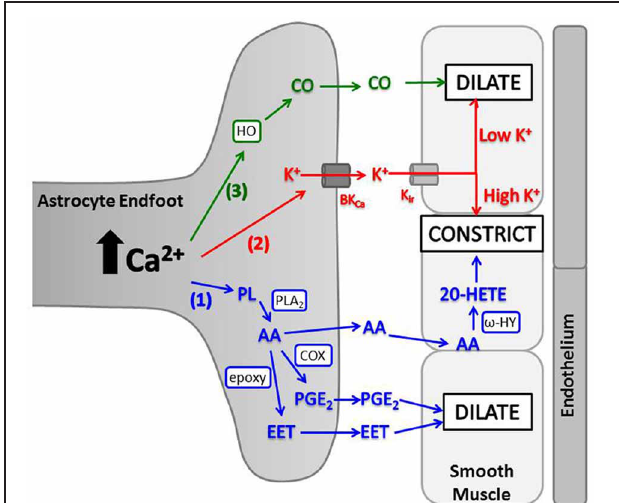
FIGURE 3 | Astrocyte intracellular Ca 2 + elevations trigger release of vasoactive molecules. (1) PLA 2 is activated by Ca 2 + and converts phospholipids (PL) to AA. AA is metabolized in astrocyte endfeet to PGE 2 (by COX) or EET [by cytochrome P450 epoxygenase (epoxy)] which dilate arterioles, or AA can diffuse to smooth muscle where ω -hydroxylase ( ω -HY) converts it to 20-HETE and causes constriction. (2) K + is released from astrocyte endfeet through BK Ca , and the amount of K + released is directly proportional to astrocyte Ca 2 + level. K + is taken up into smooth muscle through K ir and causes dilation at low concentrations and constriction at high concentrations. (3) HO is activated by Ca 2 + and produces CO, which diffuses to smooth muscle and triggers